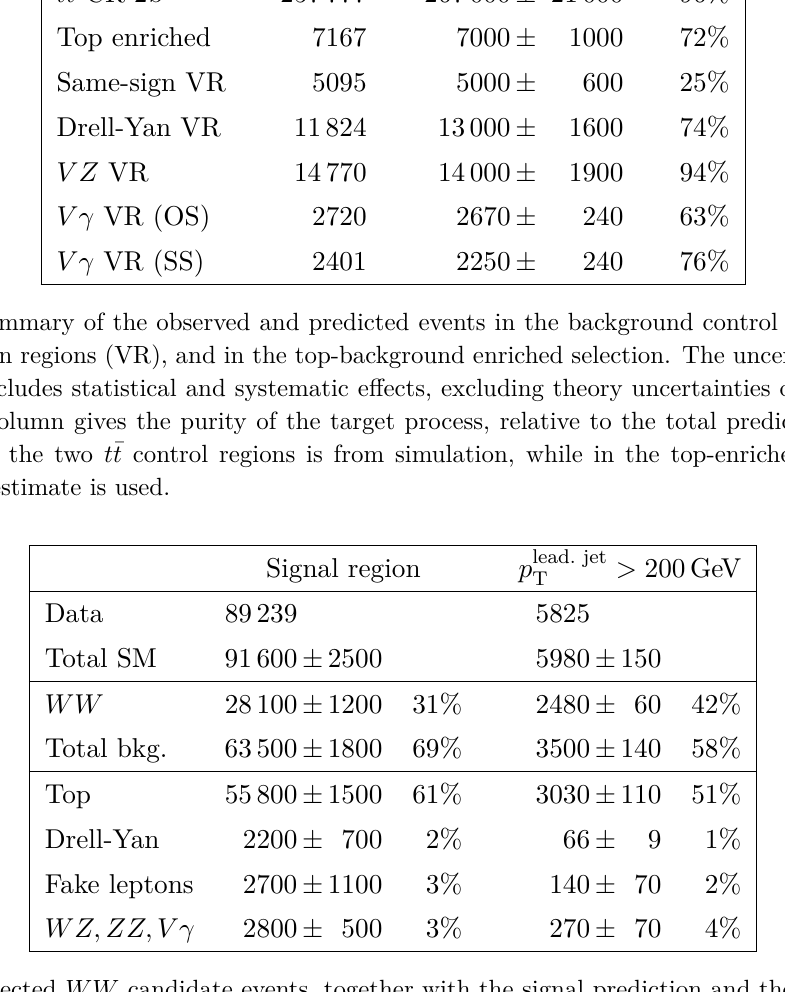
Table 4 . Selected WW candidate events, together with the signal prediction and the background estimates. The uncertainties include statistical and systematic contributions, excluding theory uncertainties on the signal. The fractions in percent give the relative contribution to the total SM prediction. The individual uncertainties are correlated, and do not add up in quadrature to the total